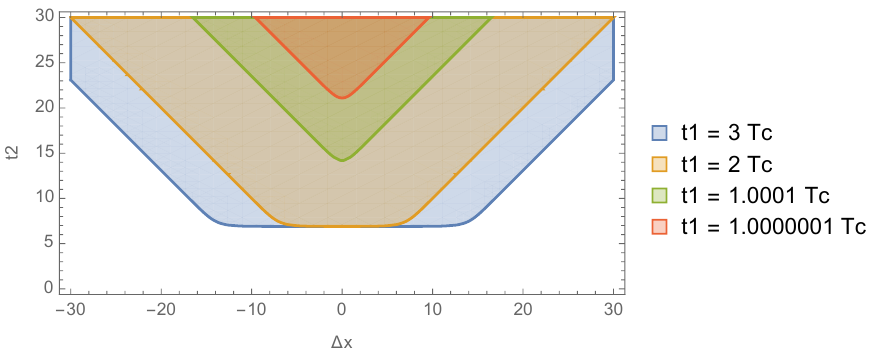
Figure 7 . This plot shows the domain of nonzero commutator (shaded regions) as a function of t 2 , the time coordinate of the future probe, and ∆ x , the relative spatial displacement of the past and future probes, as the inital probe insertion time, t 1 < 0 , is varied. As the magnitude of t 1 is decreased (particle is sent from a more recent past), the domain of the nonzero commutator shrinks and gets pushed to future